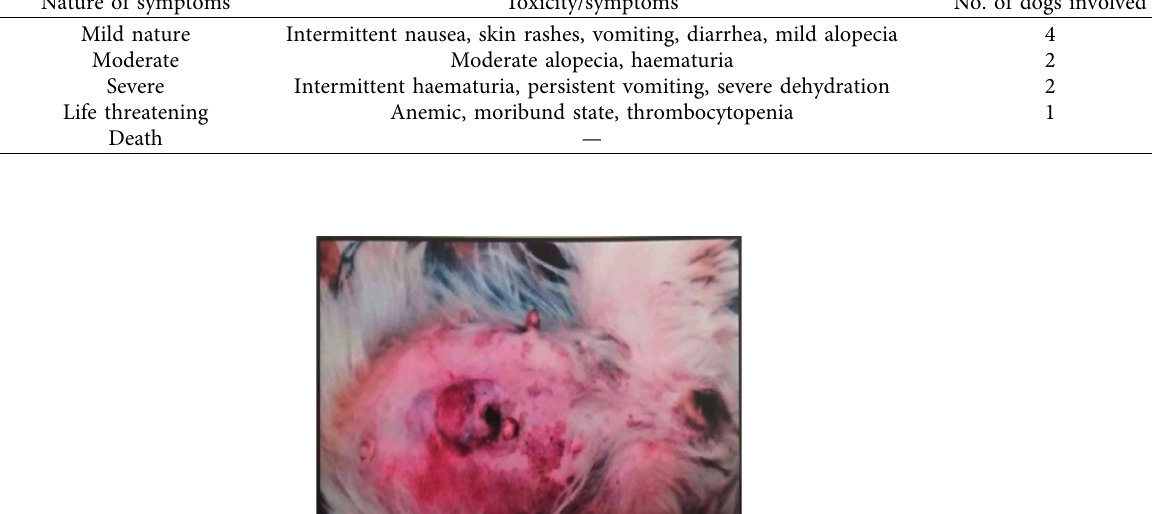
Table 3: Grading of postchemotherapeutic complications/toxicities in group II dogs (according to VCOG-AE criteria). Grades